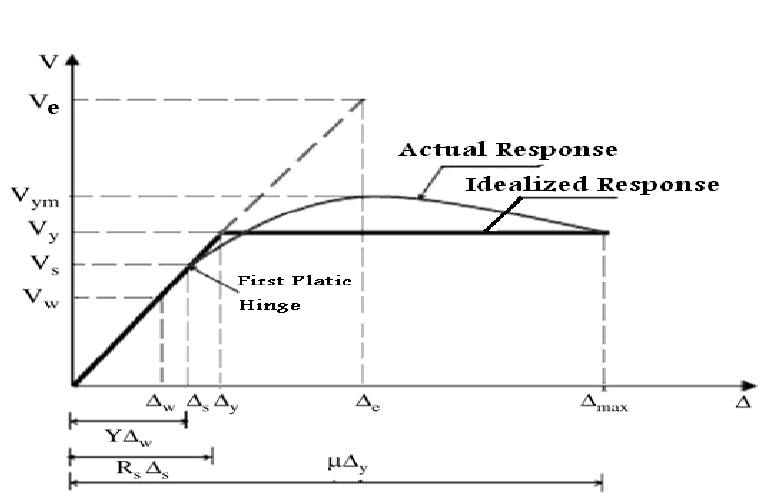
Fig. 2. Definition of nonlinear parameters (Uang,